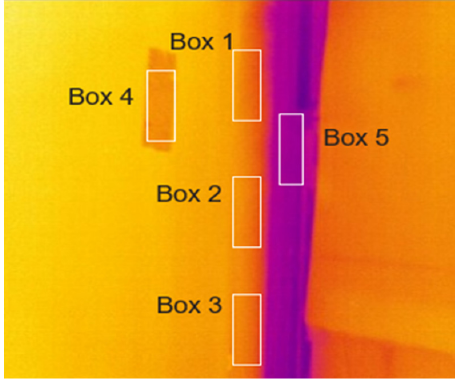
Figure 3. Regions of interest: Box 1–3: wood frame; Box 4: aluminum foil; Box 5: aluminum frame.